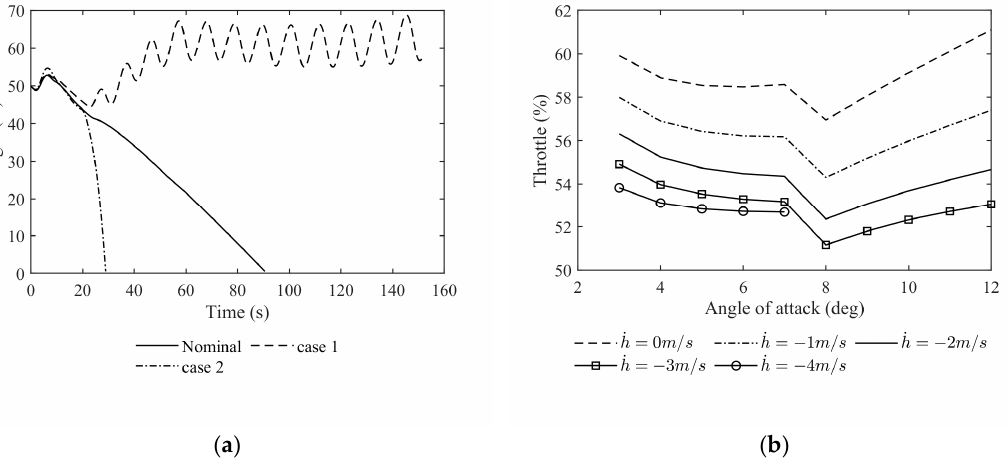
Figure 23. Simulation and analysis for the angle-of-attack control: ( a ) fixed angle-of-attack command simulation results, with Case 1 as − 20% perturbation of the nominal lift coefficient and Case 2 as +20% perturbation of the nominal lift coefficient; and ( b ) trim results for different angles of attack and sink rates (at 80 percent of lift fan’s maximum rotation speed).